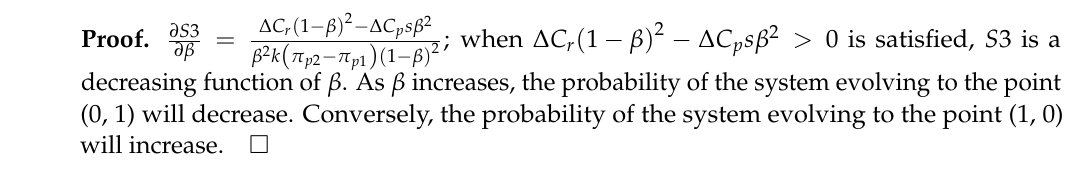
Table 20. Correlation analysis of the parameters in the second system. k s β Parameter ↑ ↑ ↑ S3 ↓ ↑ U 1